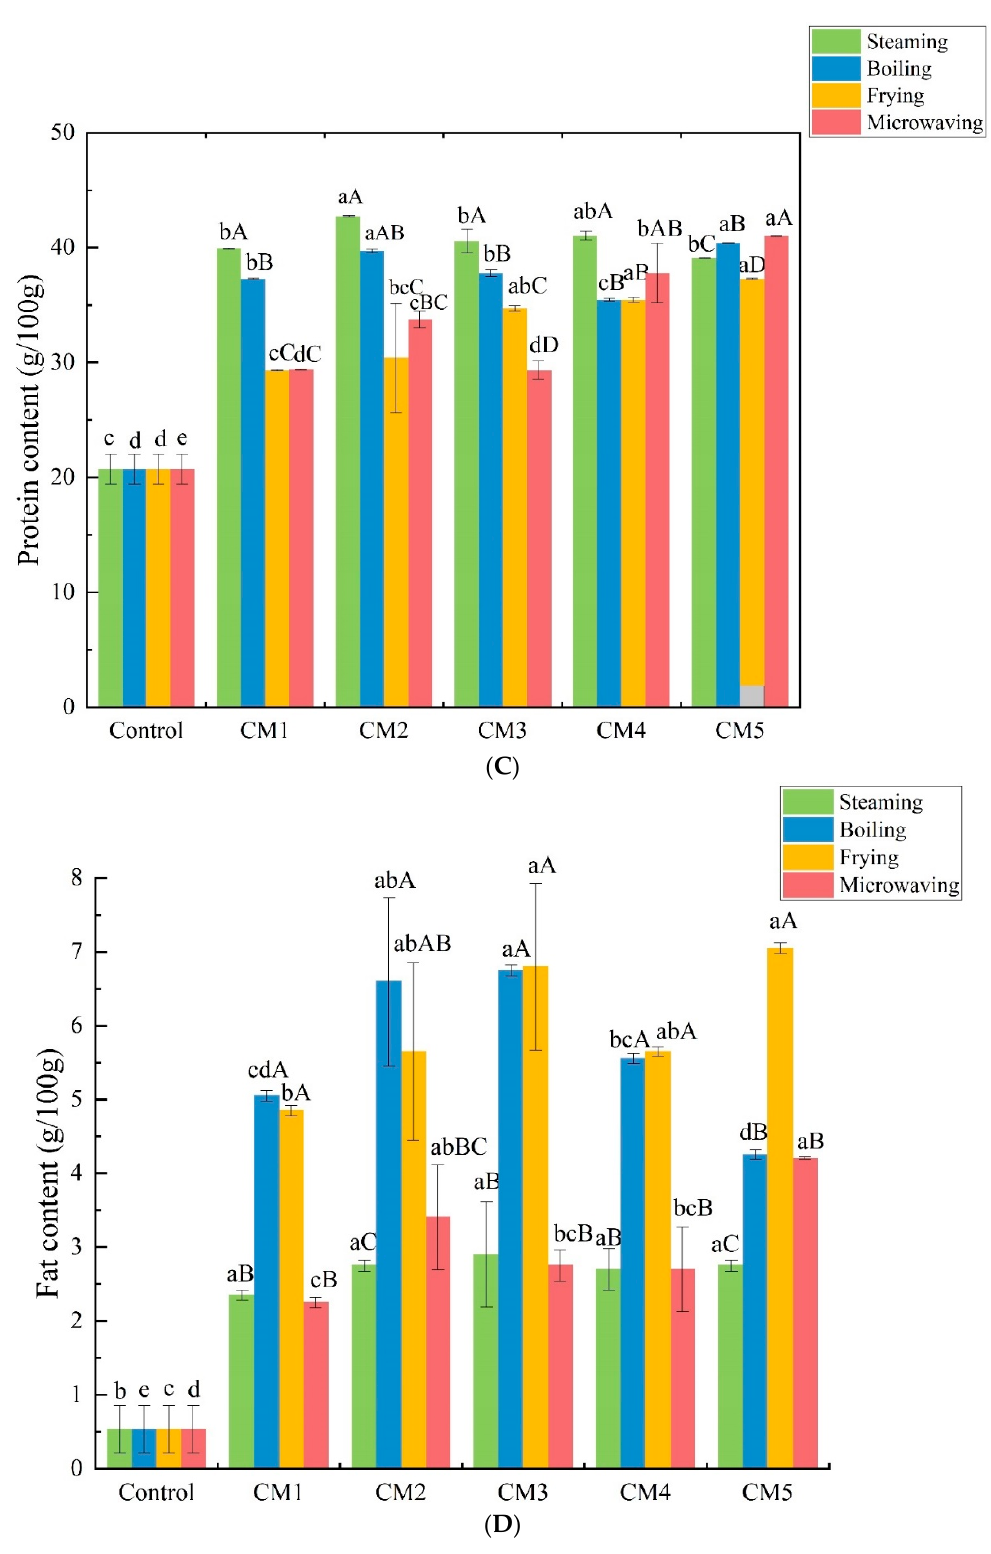
Figure 1. Comparison of basic nutrient compositions of camel meat after different heat processing methods. Subfigures ( A – D ) show the comparison graphs for moisture, ash, protein, and fat content, respectively. Different lowercase letters indicate significant differences according to the different heating times ( p < 0.05), and different capital letters indicate significant differences according to the different heating methods ( p < 0.05). The control group was untreated. The definitions of CM1, CM2, CM3, CM4, and CM5 are shown in Table 1.